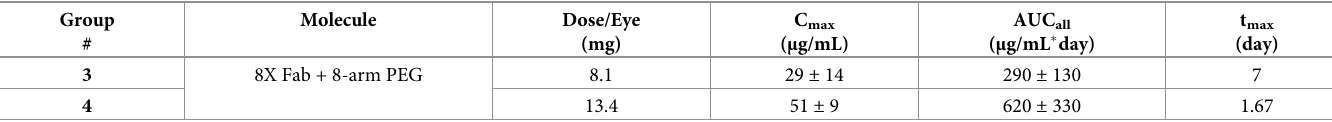
Table 4. NHP serum results for 8X Fab + 8-arm PEG. Toxicokinetic parameters are reported on the basis of active ingredient (Fab) content. Group